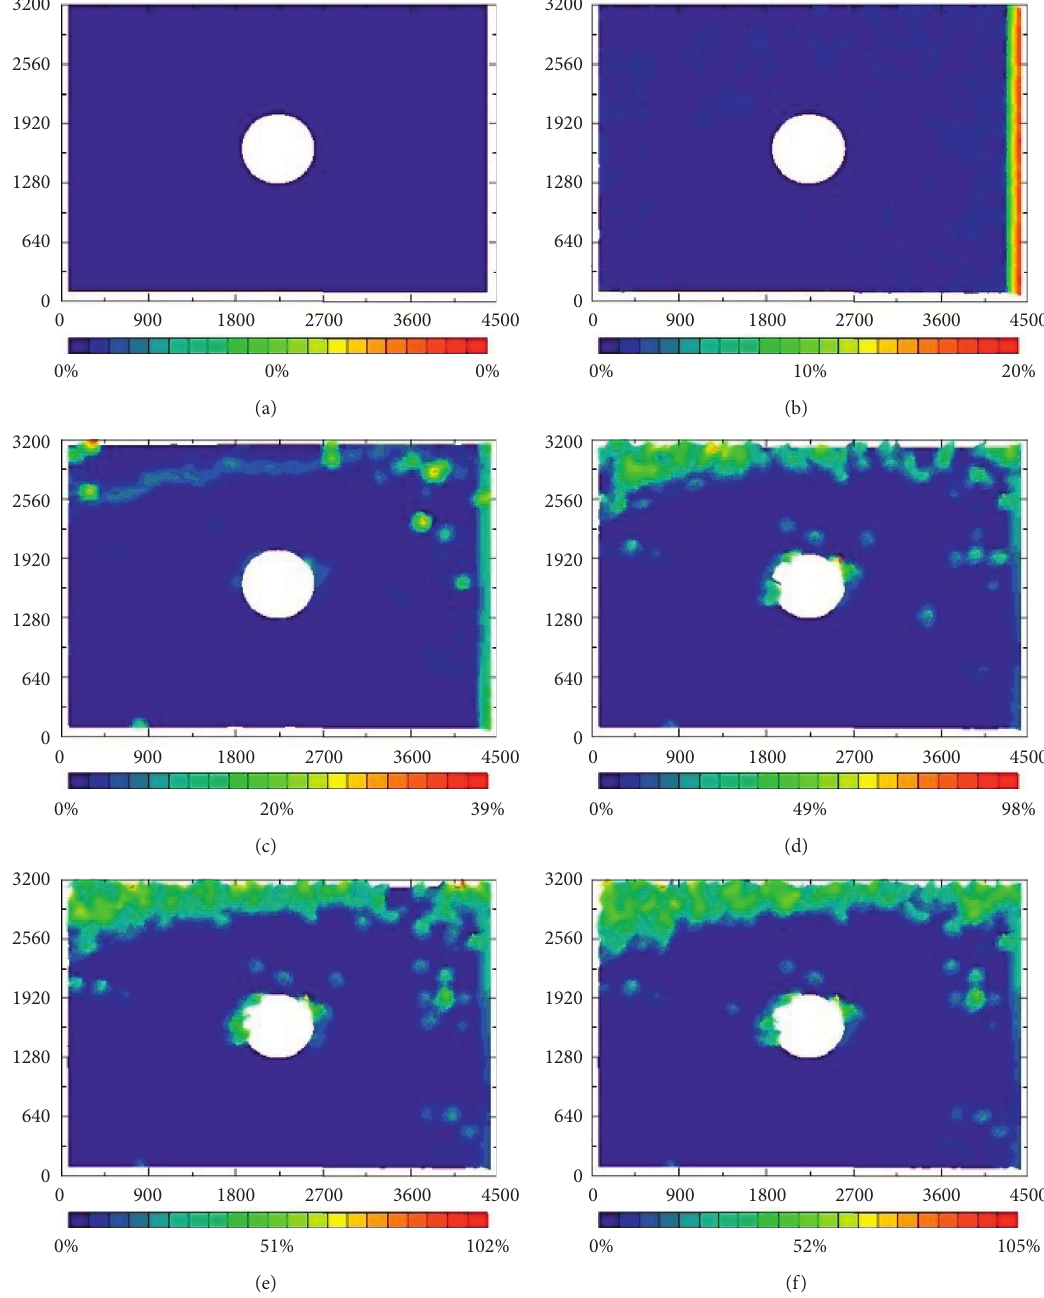
Figure 19: Maximum shear strain cloud image with support model. (a) 0.25MPa. (b) 0.32 MPa. (c) 0.48 MPa. (d) 0.58MPa. (e) 0.63 MPa. (f)